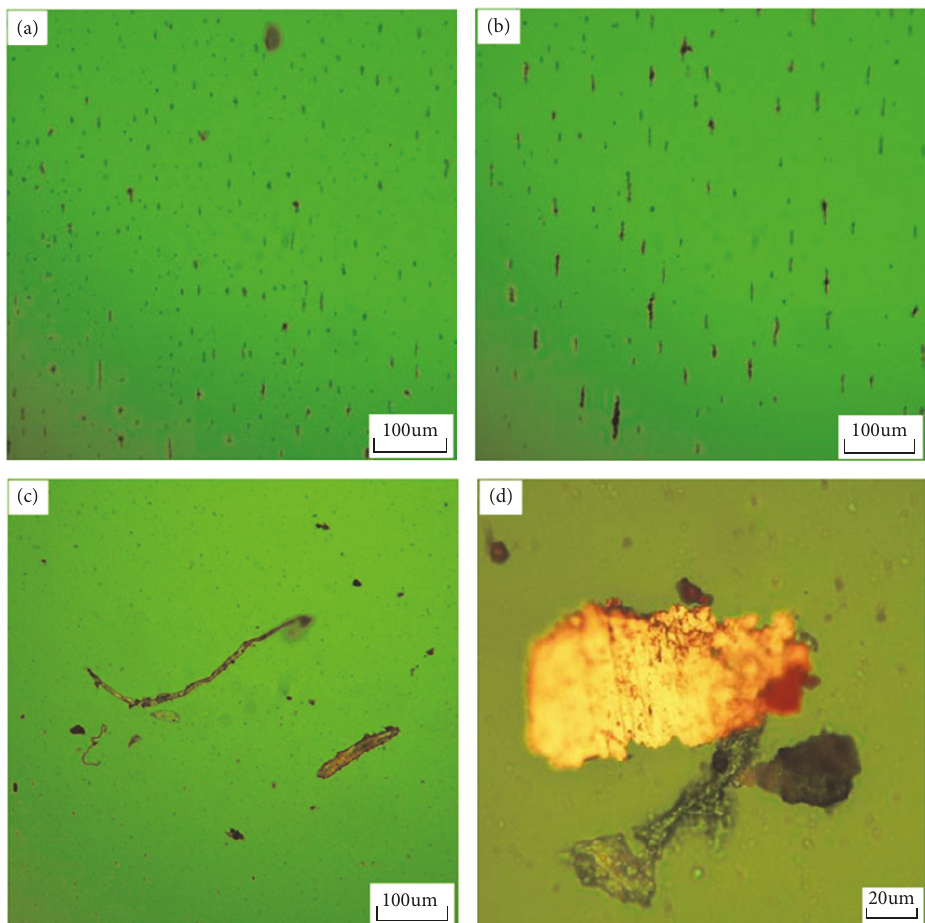
Figure 12: Abrasive grain morphology under different torque loads. (a)7.2Nm, (b)21.3Nm, (c)42.4Nm, and